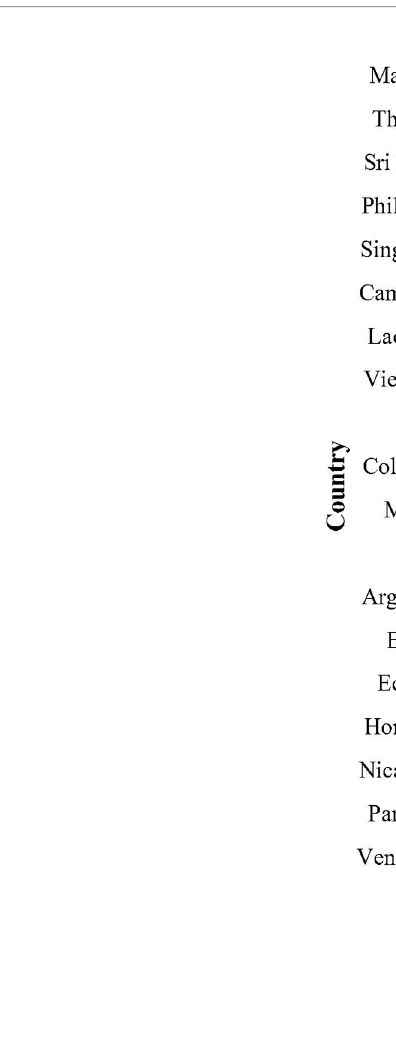
FIGURE 3 | The change rate of noti fi ed dengue case during COVID-19 in Asia and Americas. Change rate= (the number of dengue cases in 2020 or 2021 - the average number of dengue cases in 2015-2019)/ (the average number of dengue cases in